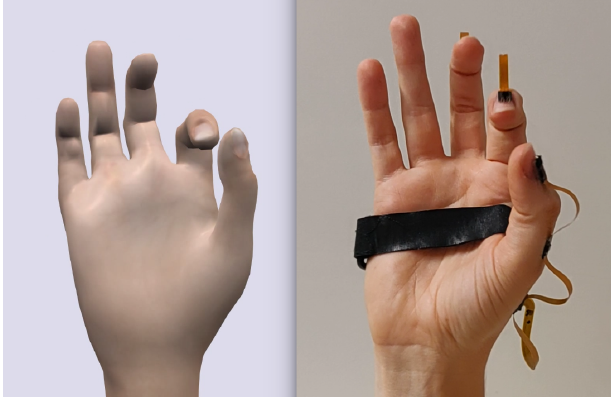
Figure 2. 3D real-time visualization of the measured hand